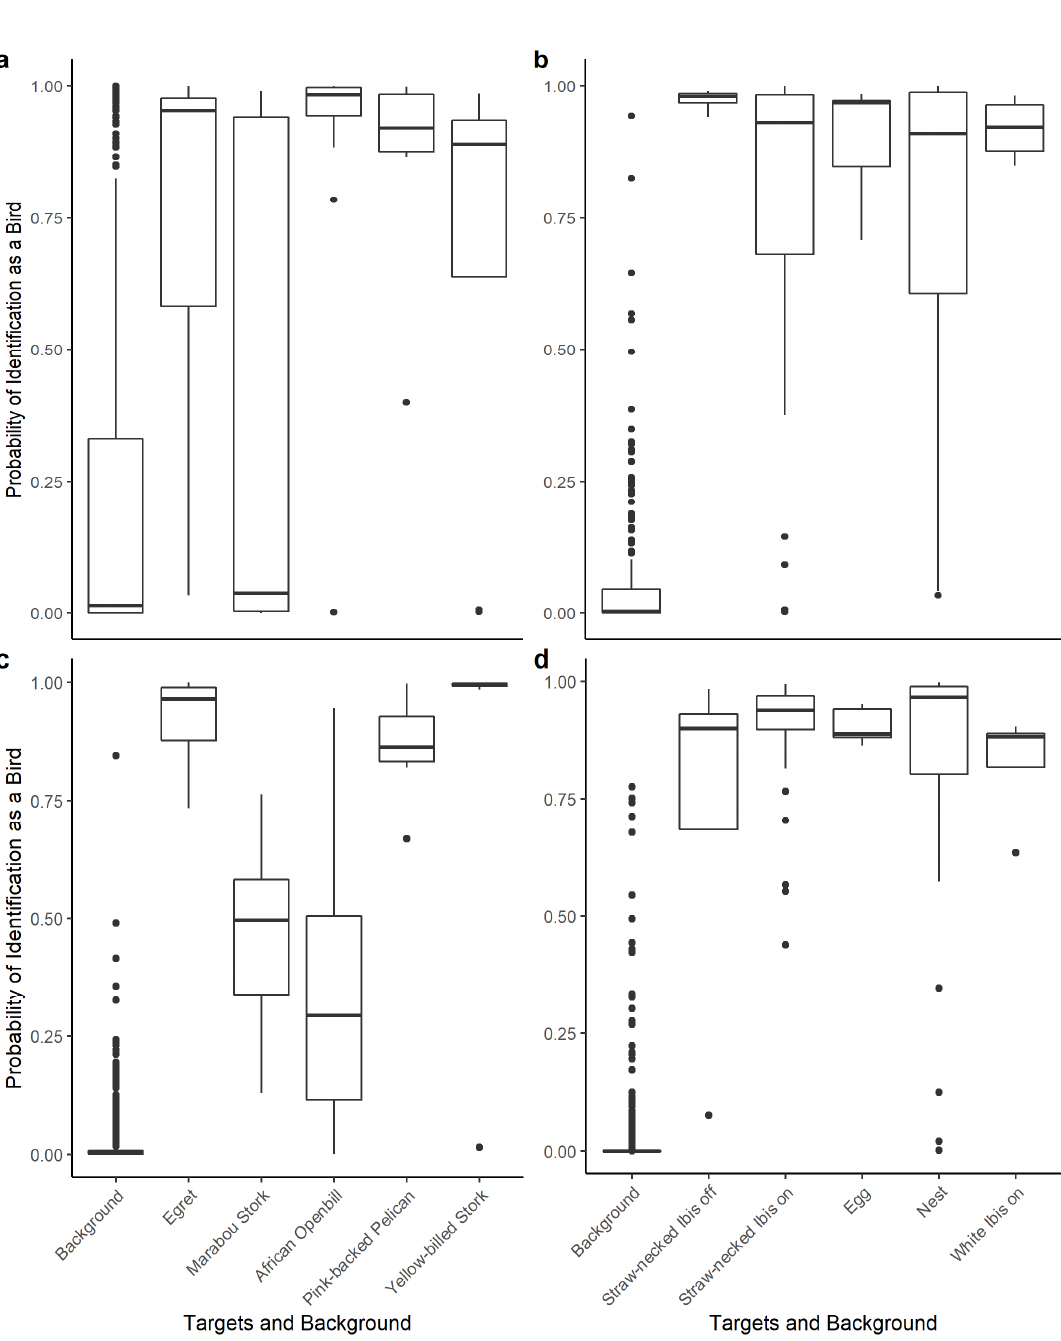
Figure 3. The boxplot used to identify classification errors between targets and background using 99% thresholding for the freeware method at ( a ) the Kanana colony and ( b ) the Eulimbah colony, and the payware method at ( c ) Kanana and ( d ) Eulimbah. At the Eulimbah colony, birds were identified as being either on or off their nests.